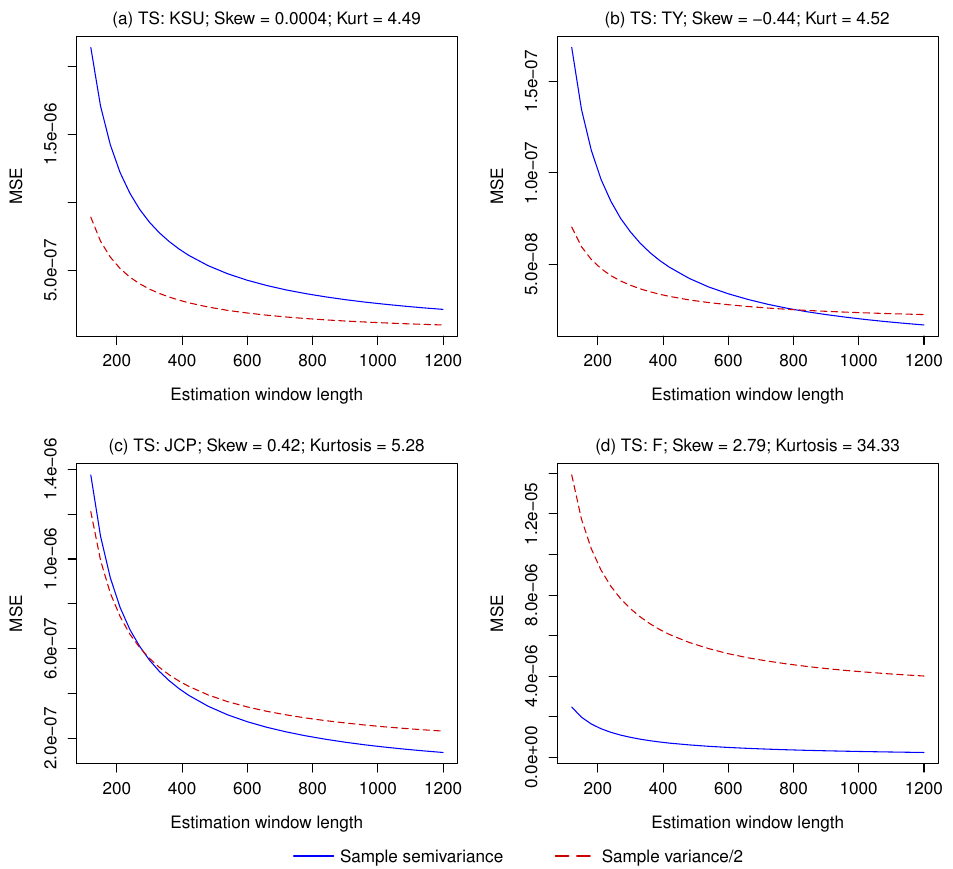
Figure 3. Mean Squared Error of the sample semivariance and the sample variance/2 used as estimators for the semivariance of a series of returns. ( a ) Virtually symmetrically distributed returns; ( b ) Negatively skewed returns; ( c ) Positively skewed returns; ( d ) Very positively skewed returns. Unsurprisingly, when the return distribution is approximately symmetric, the lowest MSE is obtained by estimating the semivariance as half of the sample variance. When the skewness is equal to − 0.44, the sample semivariance only has a lower MSE with an estimation window of about 800 periods or more. With a skew equal to 0.42, the sample semivariance becomes competitive with just 300 periods. Finally, with a very positive skew of 2.79, the MSE of the sample semivariance is always lower than that of the sample variance divided by